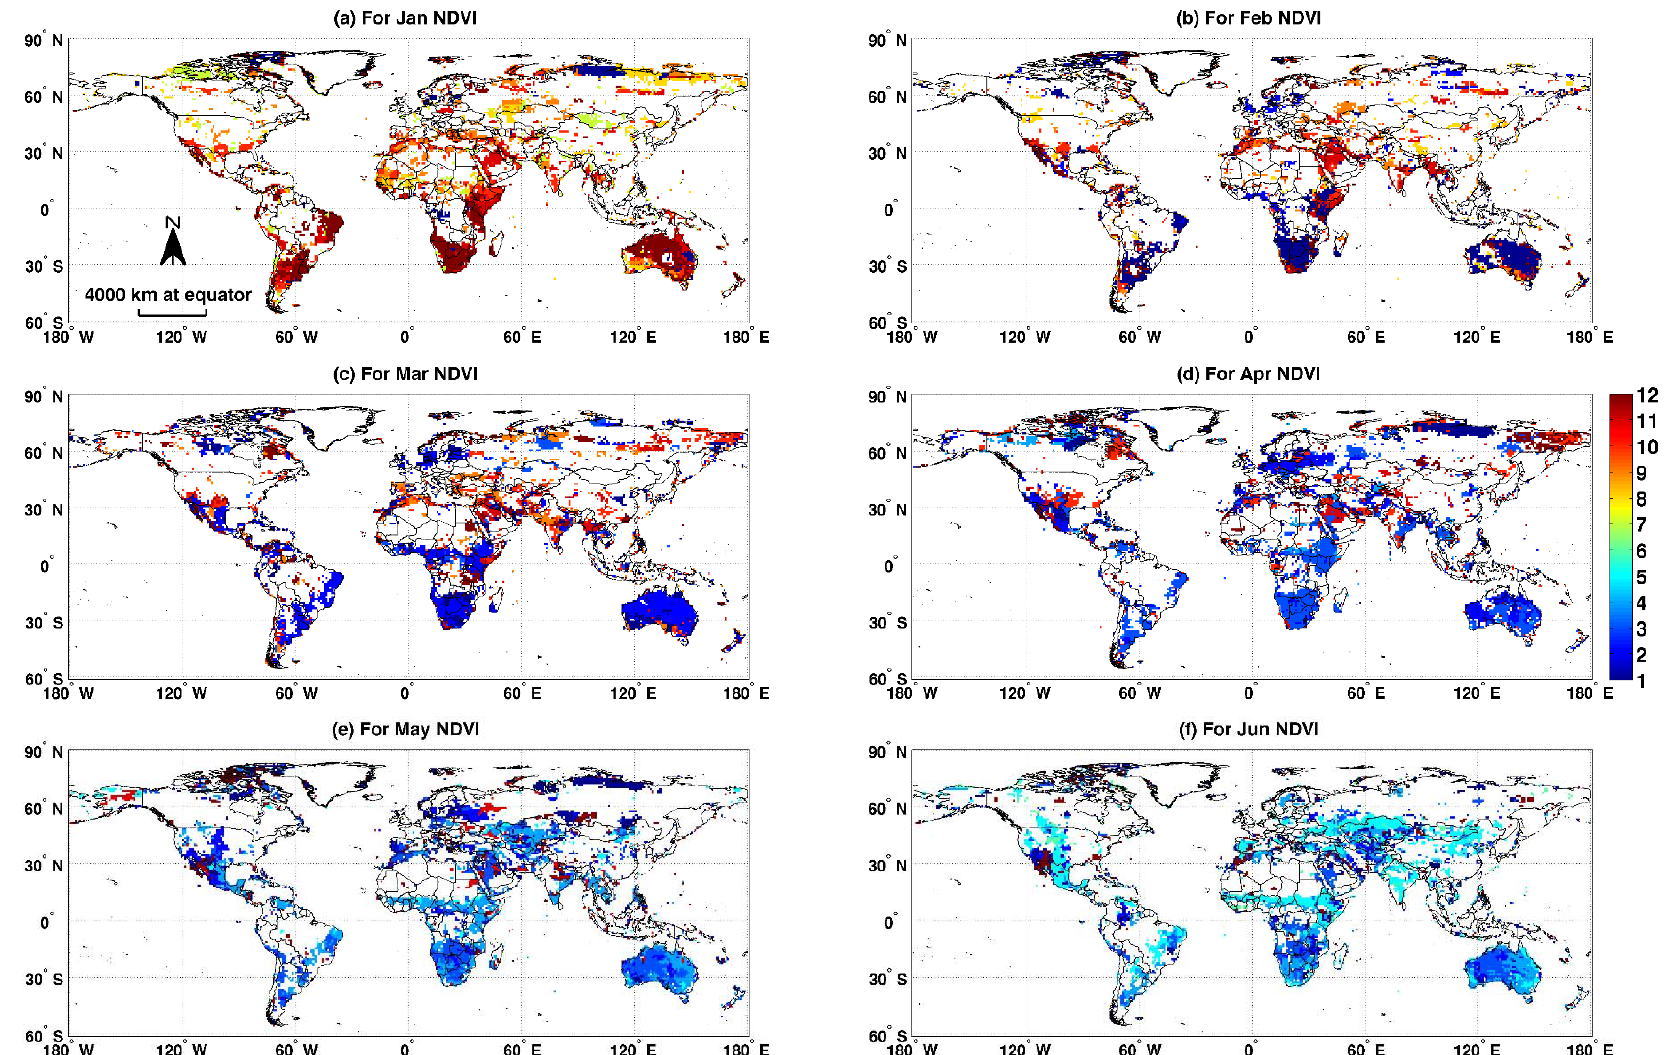
Figure 3. Month of which precipitation is most strongly correlated (positively, N = 29, 1982 to 2010) with GIMMS NDVI of a particular month. For each of the 12 months (a – l) , NDVI is generally most dependent on precipitation 1 month ahead (Spatial resolution: